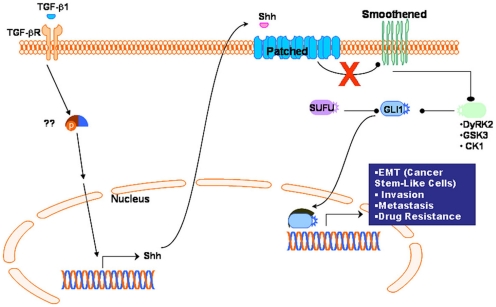
Schematic diagram showing activation of TGF-β receptor by TGF-β1which leads to the up-regulation of Shh expression.The secreted Shh protein then activates Hh signaling pathway by inhibition of Patched (smoothened suppressor), which will repress smoothened, resulting in the activation of GLI1 and its translocation to the nucleus. GLI1 as a Hh transcription factor then could activate Hh target genes, which leads to the acquisition of EMT phenotype, and contributing to increased invasion, metastasis and drug resistance.